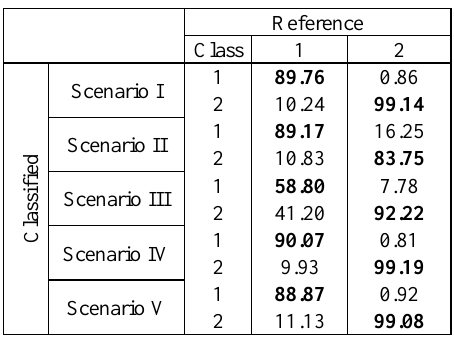
Table 3. Confusion matrix for the conducted